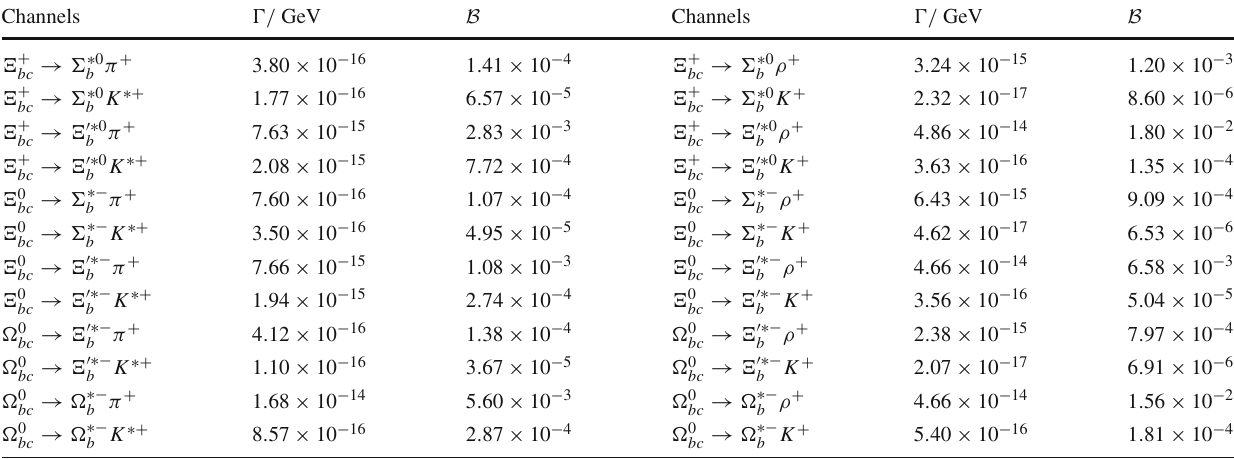
Table 18 Nonleptonic decays for the bc sector with c quark